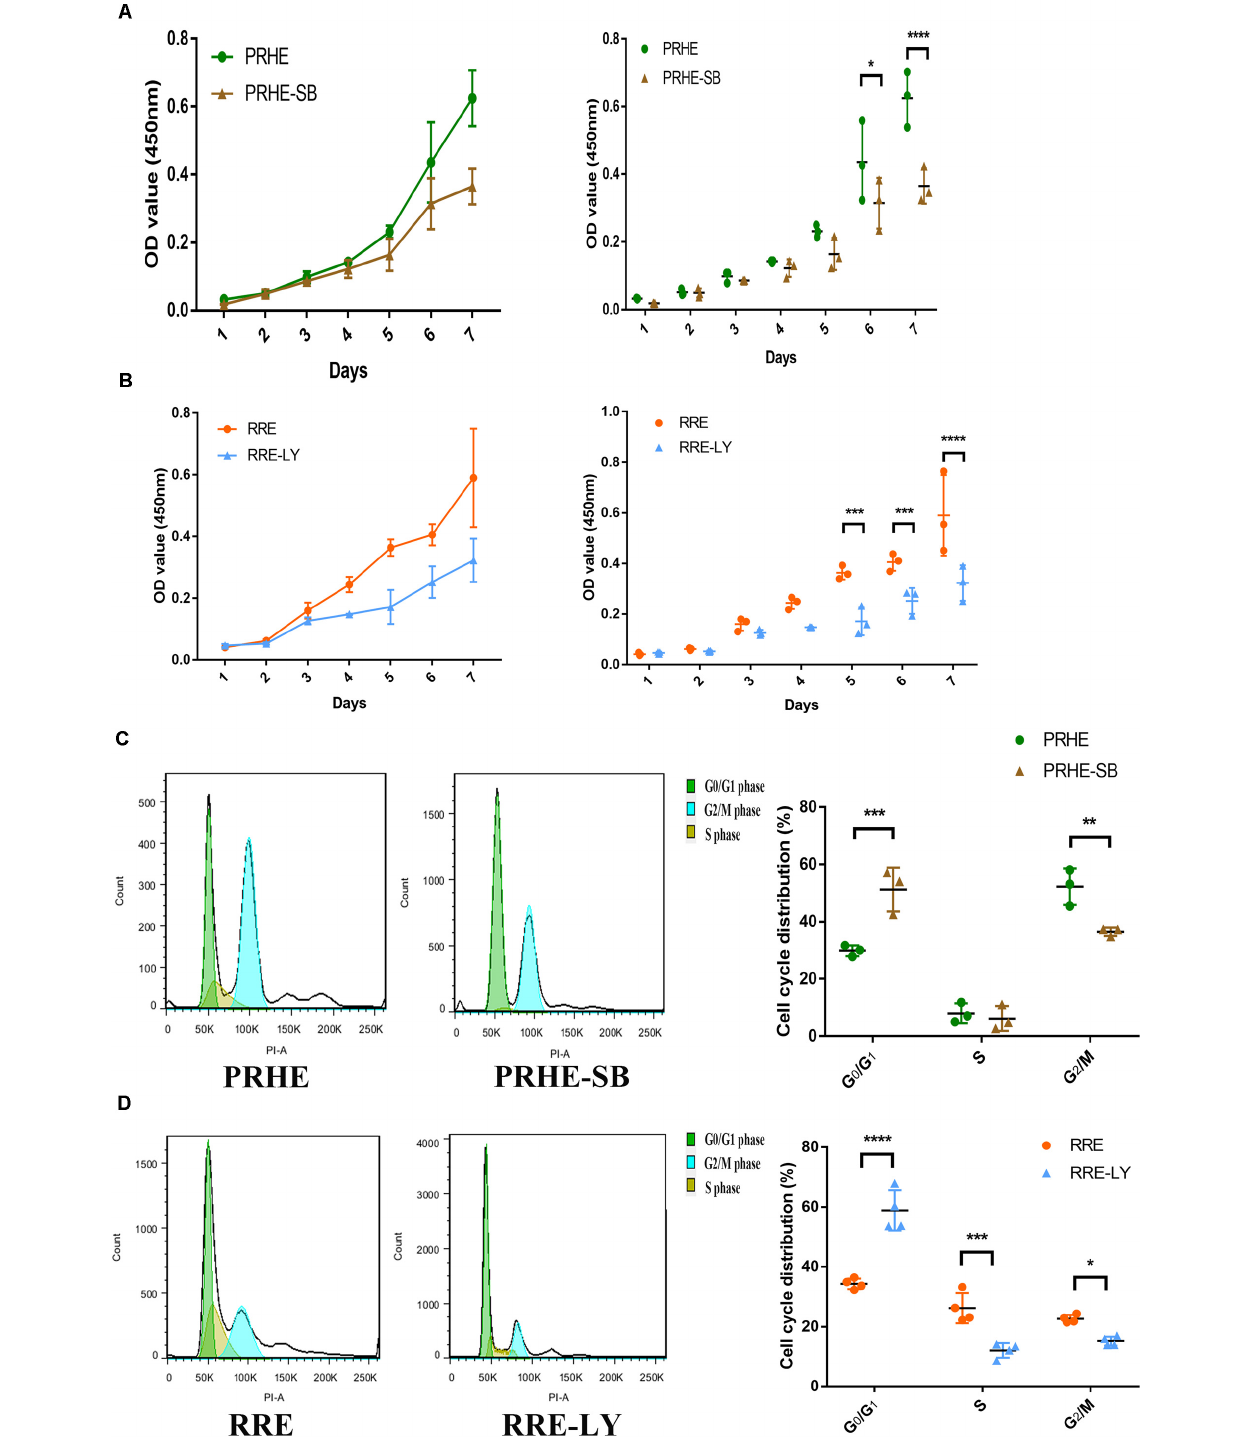
FIGURE 13 | Inhibition of the TGF β and PI3K pathways decreased the proliferative capacities and cell cycle transitions of ESCs-cocultured premature and replicative senescent RPE cells. (A) Proliferation of the PRHE and PRHE-SB groups, as assessed by a CCK-8 proliferation assay ( n = 3 biological repeats). (B) Proliferation of the RRE and RRE-LY groups, as assessed by a CCK-8 proliferation assay ( n = 3 biological repeats). (C) Proportion of cell cycle distribution in the PRHE and PRHE-SB groups, as assessed by flow cytometry ( n = 3 biological repeats). (D) Proportion of cell cycle distribution in the RRE and RRE-LY groups, as assessed by flow cytometry ( n = 4 biological repeats). Data are presented as the mean ± SD. ∗ P < 0.05; ∗∗ P < 0.01; ∗∗∗ P < 0.001; ∗∗∗∗ P < 0.0001.